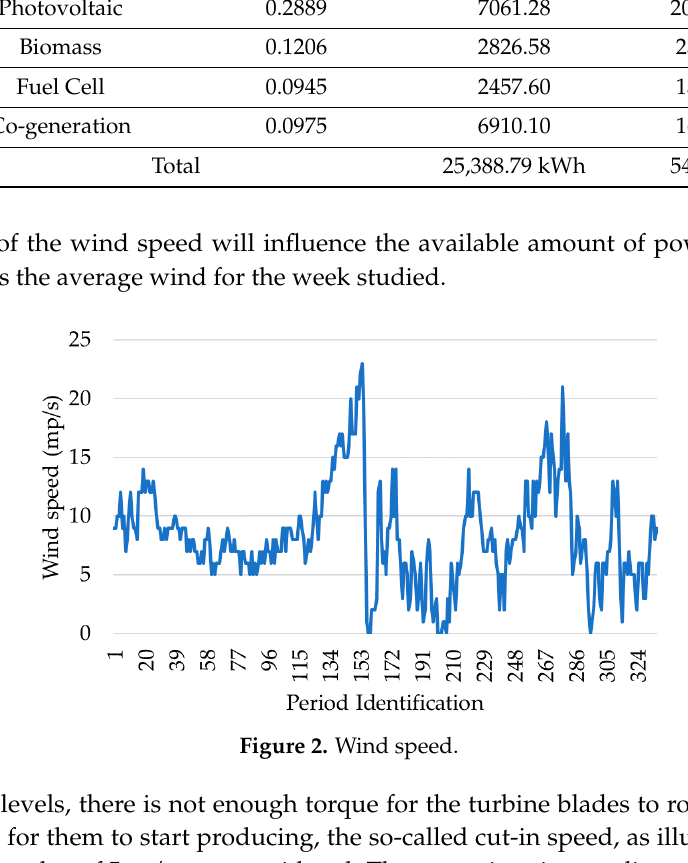
Figure 3. Cut-in and cut-out speed. The aggregator is responsible for specifying these characteristics for each resource, in order to obtain proper results for this methodology. In this paper, the focus has been on studying consumers. Thus, three different scenarios (WD, W, and WW) were created to study the influence of aggregation on the remuneration of this type of resource, as presented in Figure 4. The definition of the number of clusters to be formed is decided by the VPP. In this paper, k = 1 wasn’t an option because would